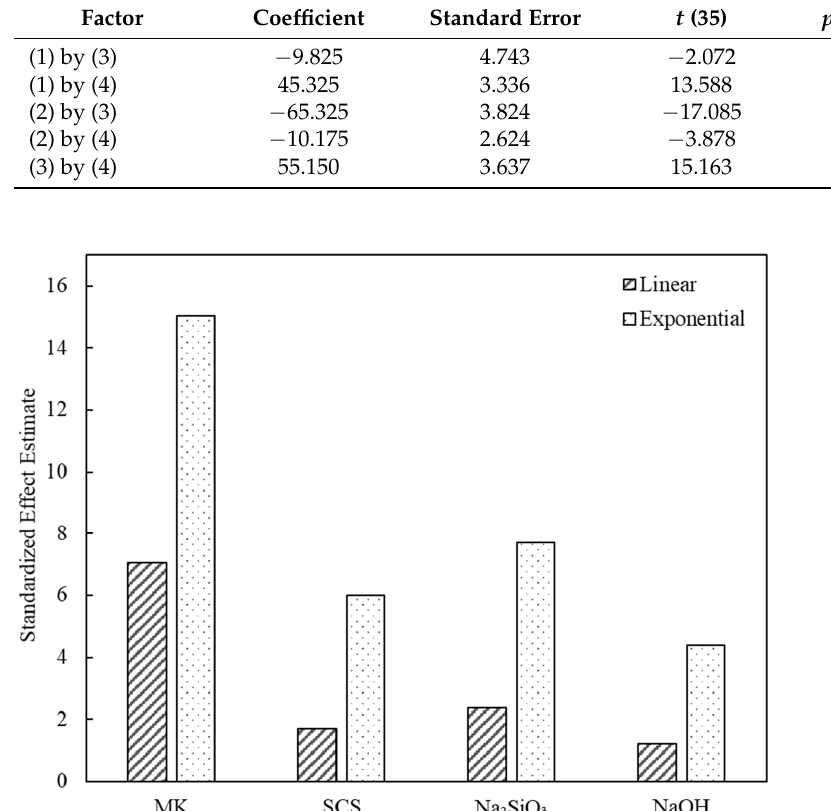
Figure 2. Statistical analysis results of standardized effects between compressive strength and raw materials of the SCSGPs. Table 4. Multiple regression analysis for compressive strength and raw materials of the SCSGPs (r 2 = 0.984).